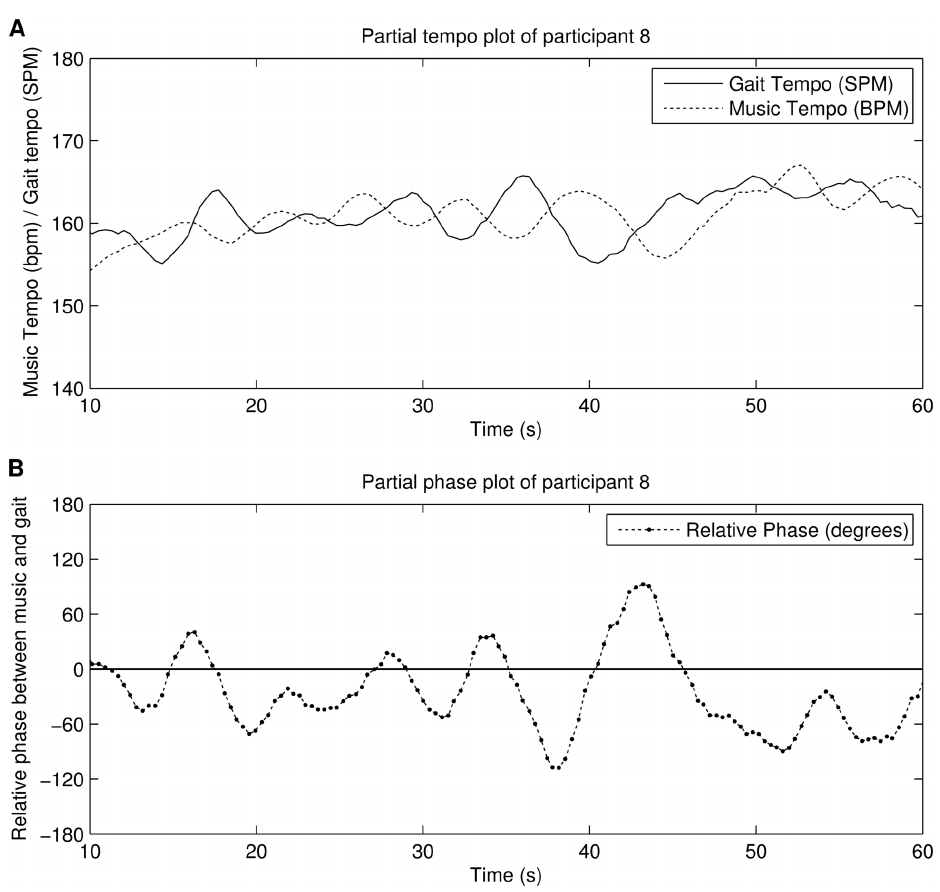
Fig. 7. Excerpt from the experiment of alignment strategy 1 (period-adaptive phase-random). Figure A shows the tempo plot, figure B shows the phase evolution per step. Figure A and B show the wobbling pattern often found in the